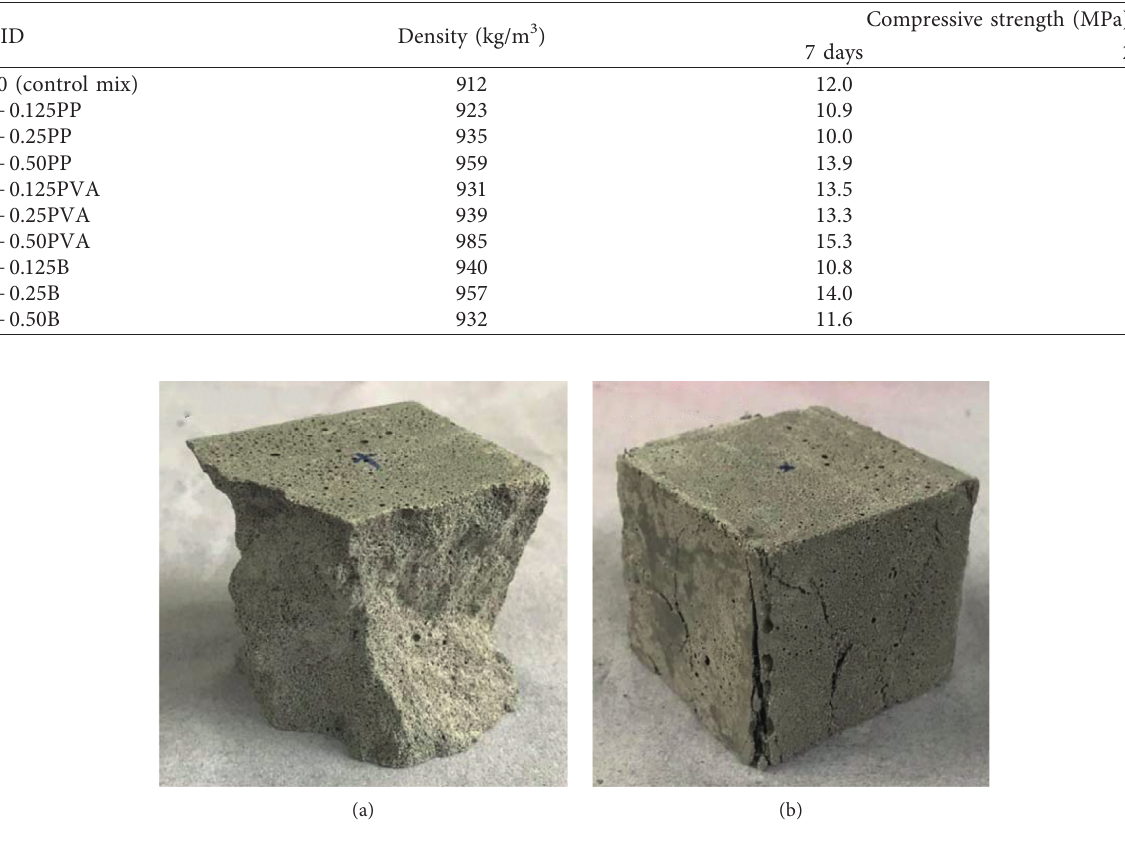
Figure 5: Failure pattern of LCC (a) without fibre; (b) with